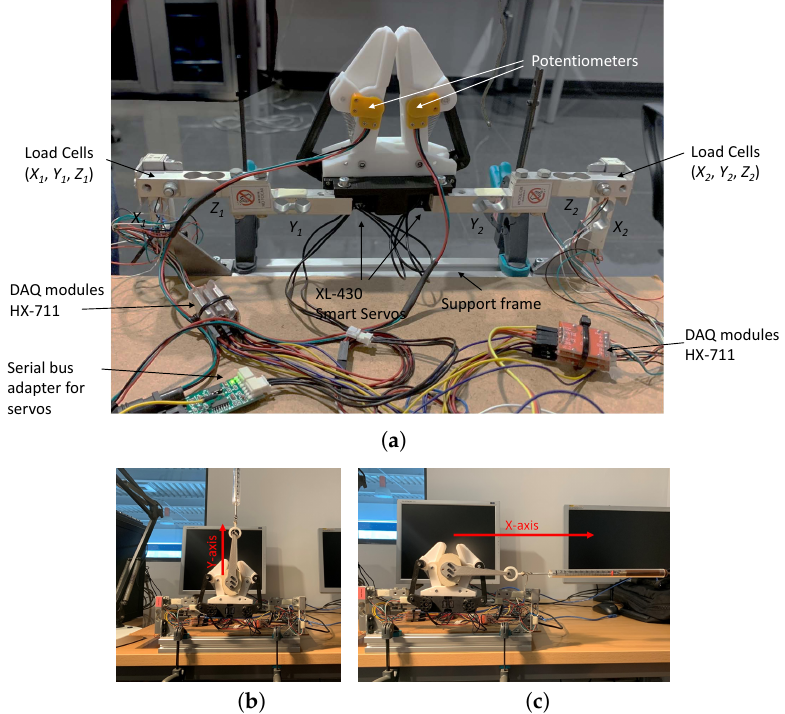
Figure 5. Experimental setup ( a ) and calibration process for Y-axis ( b ) and X-axis ( c ) forces. A dummy forearm section is used to calibrate the force sensor used to get ground-truth values for the force estimation